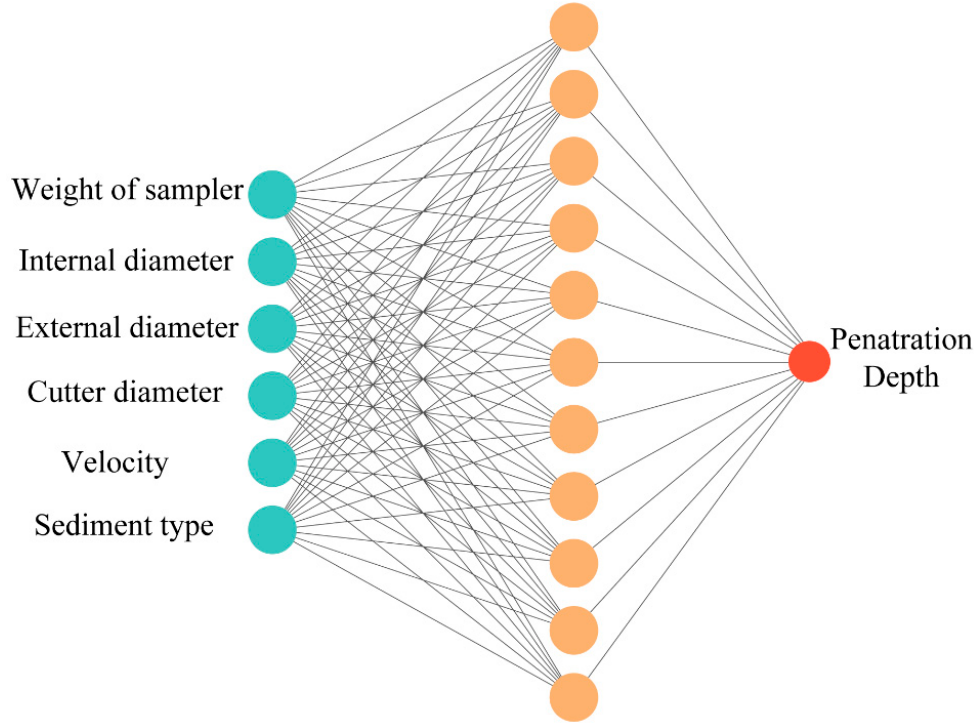
Figure 3. Illustration of the penetration depth prediction neural network. The green nodes, brown nodes, red nodes represent input node, hidden nodes and output nodes,